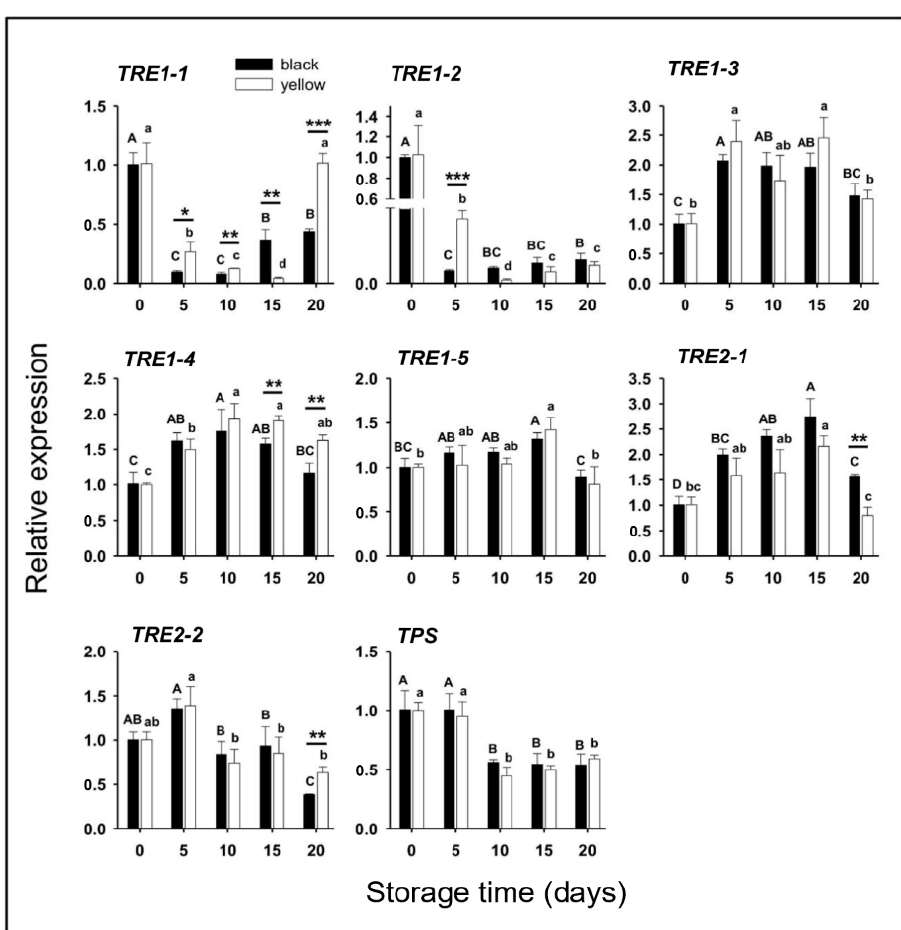
Figure 5. Changes in the mRNA expression levels of seven trehalase genes and one TPS gene in H. axyridis yellow (non-melanic) and black (melanic) adults in the experimental (indoor) population under cold storage (0–20 days). The relative levels of the target genes were calculated according to the Harp49 ( H. axyridis ribosomal protein 49 gene) expression level with RT-qPCR. Bars represent the mean (+SD) of three replicates. The gene expression level at 0 d of cold storage was used as the control group. Bars with different letters indicate significant differences (one-way ANOVA, p ≤ 0.05). Asterisks indicate significant differences between yellow and black adults in the same storage period ( t -test, *** p ≤ 0.001; ** p ≤ 0.01; * p ≤ 0.05).